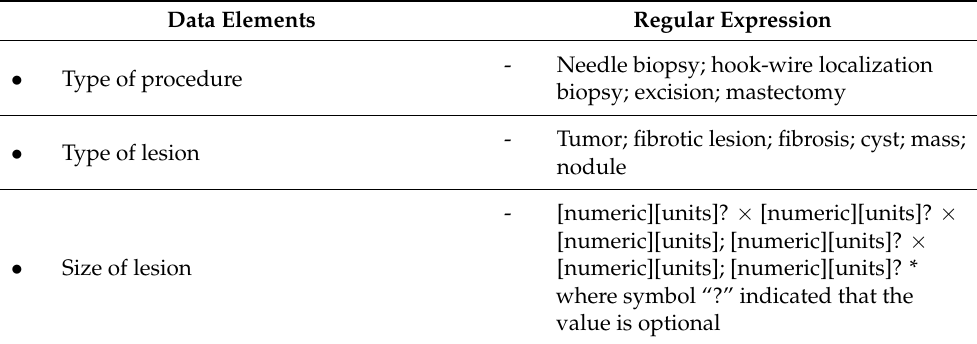
Table 2. Variables extracted with its regular